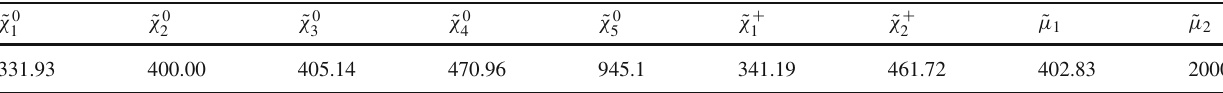
Table 2 Electroweakino and smuon masses in GeV for the parameter point P1 ˜ χ 0 1